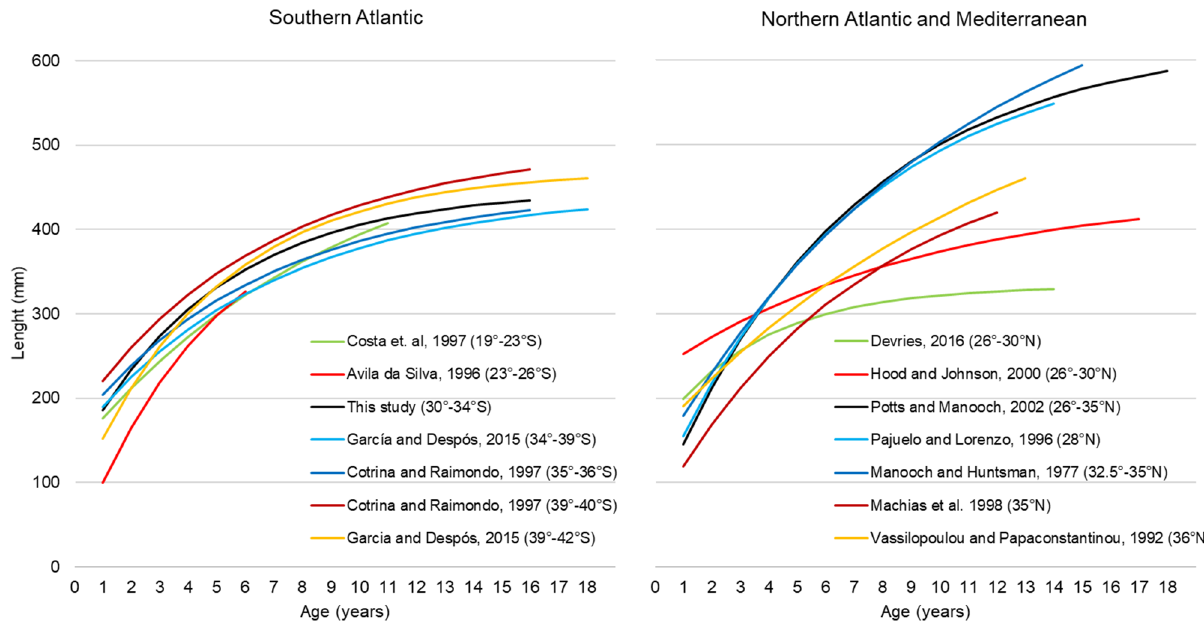
Fig. 14. Von Bertalanffy growth curves of Pagrus pagrus for the southwestern Atlantic (left) and the northern Atlantic and Mediterranean Sea (right) for which age determinations on scales or otoliths was validated. For consistent comparisons, lengths-at-age were standardized to total length, measured from the snout to the tip of the upper limb of the tail in the normal position, as used in this study. A factor of 0.97 was applied to the length measured from the snout to the extended caudal fi n and a factor of 1.19 to convert fork